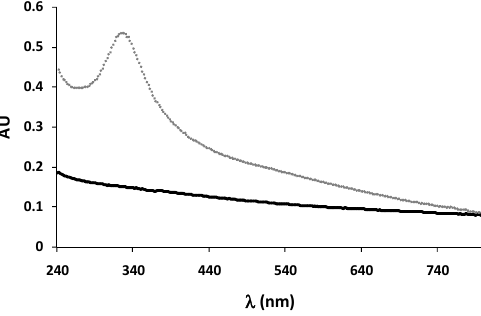
Figure 3. UV-visible spectra of DHI (black trace) and DHICA melanin (gray trace) at pH 7.5.